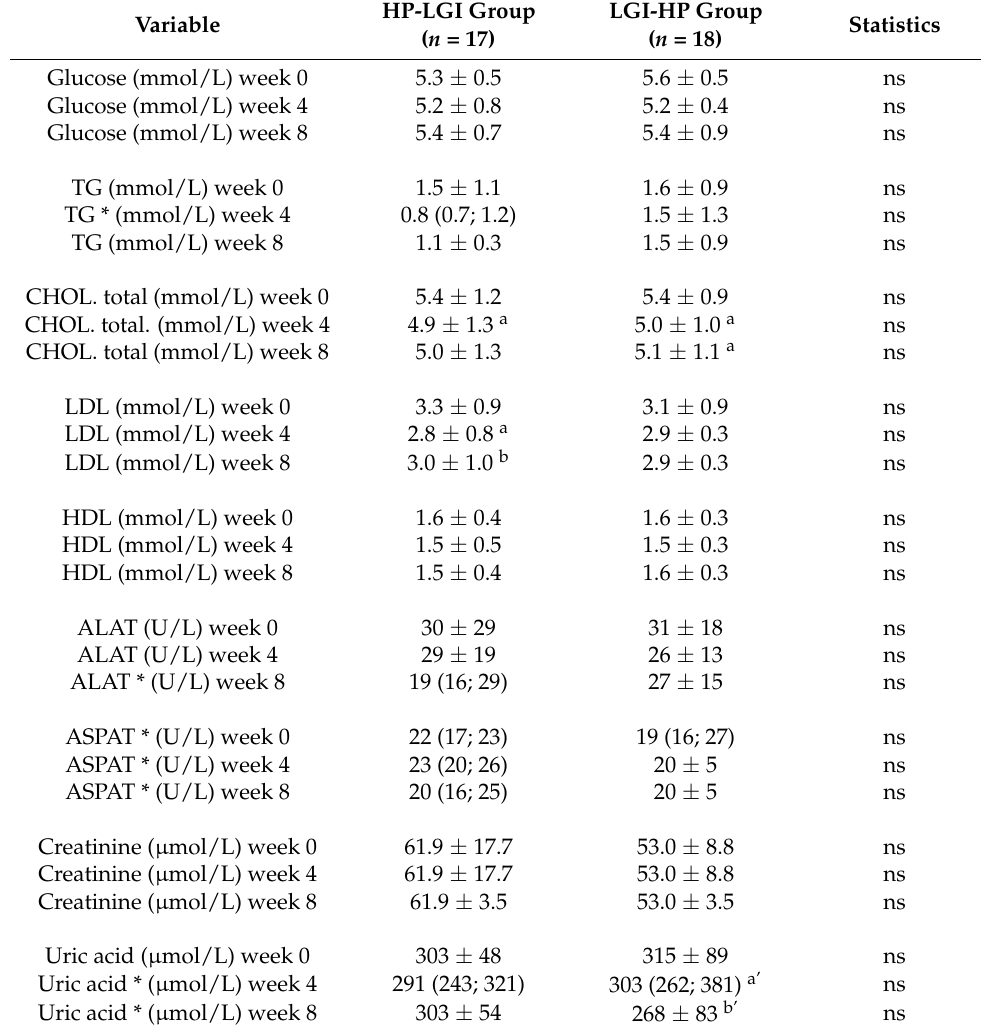
Table 4. The changes in laboratory parameters during the energy-restricted HP and LGI